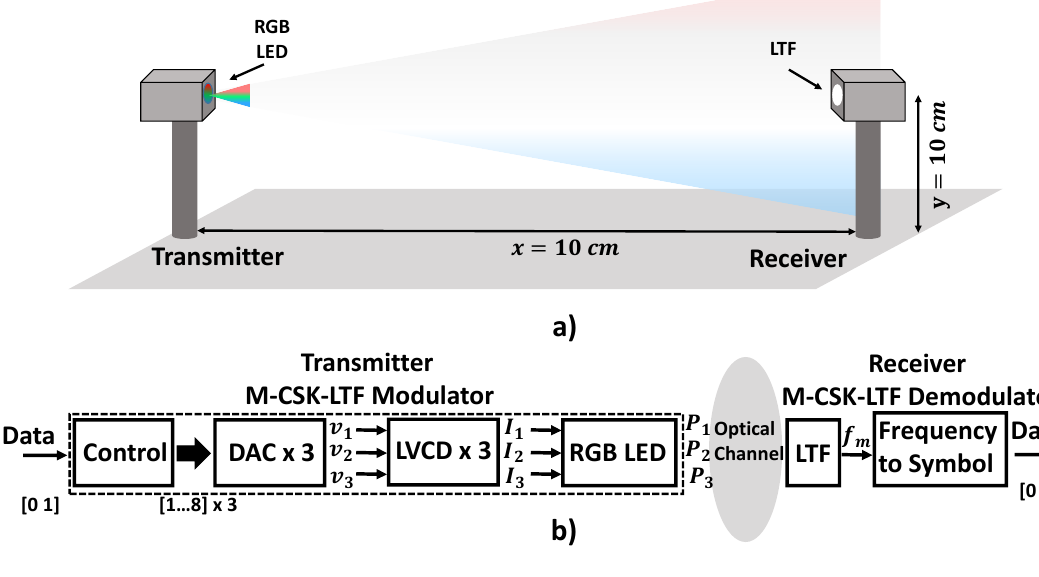
Figure 2. Proposed VLC-CSK-LTF system. ( a ) Experimental setup. ( b ) Diagram of the